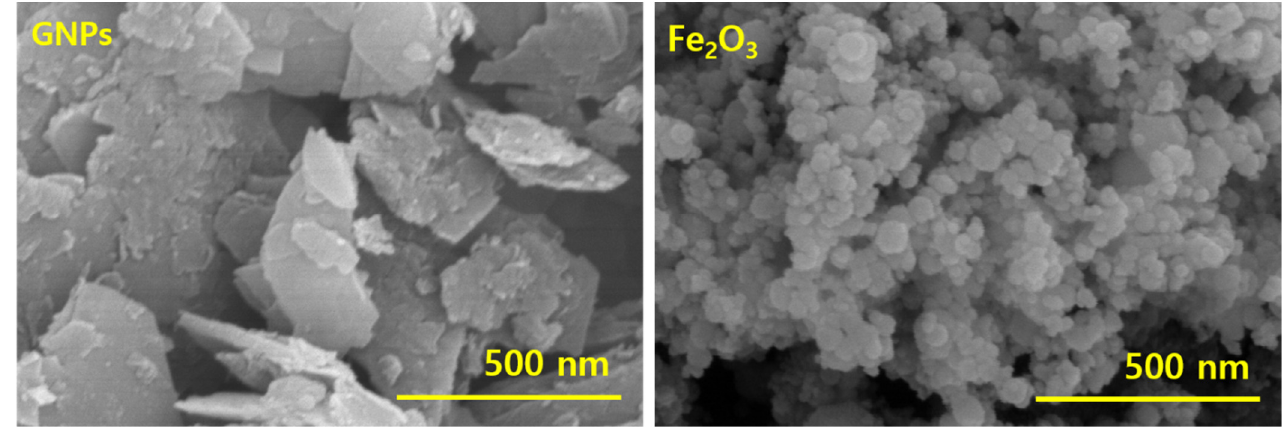
Figure 2. SEM showing GNPs and Fe 2 O 3 .